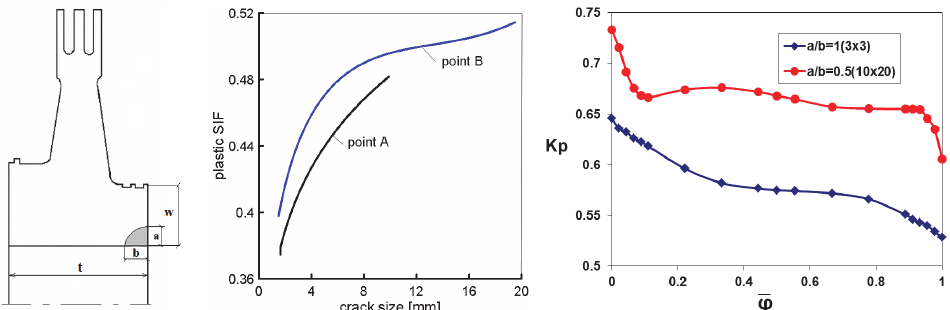
Figure 6: Plastic SIF as a function of crack size and front